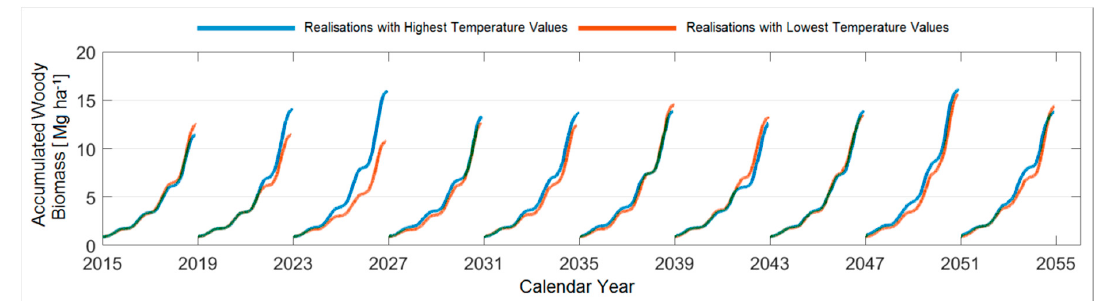
Figure A4. Projected woody biomass of poplar trees under special realisations describing either the highest temperature values (blue) or the lowest temperature values (orange) with respect to the ten established growing periods.